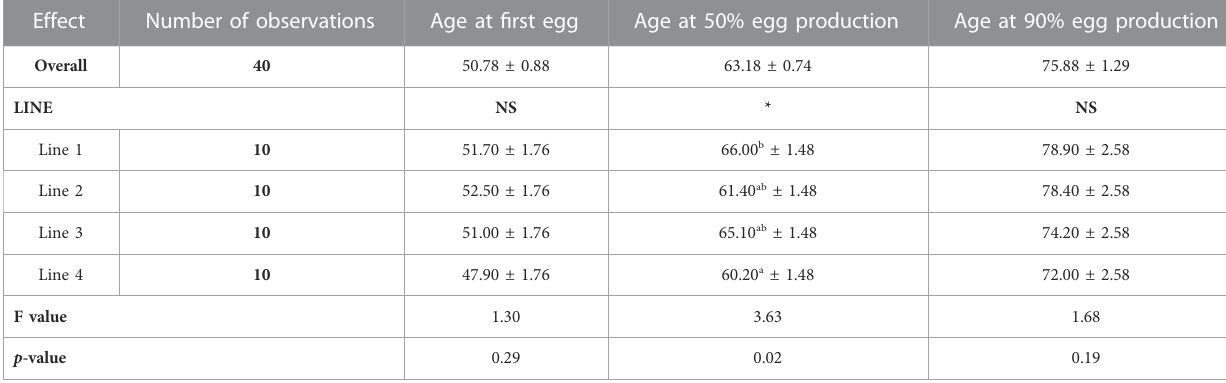
TABLE 4 Means (±S.E.) of age (days) at fi rst egg, age at 50 per cent and 90 per cent egg production of different lines of Japanese quail. Effect